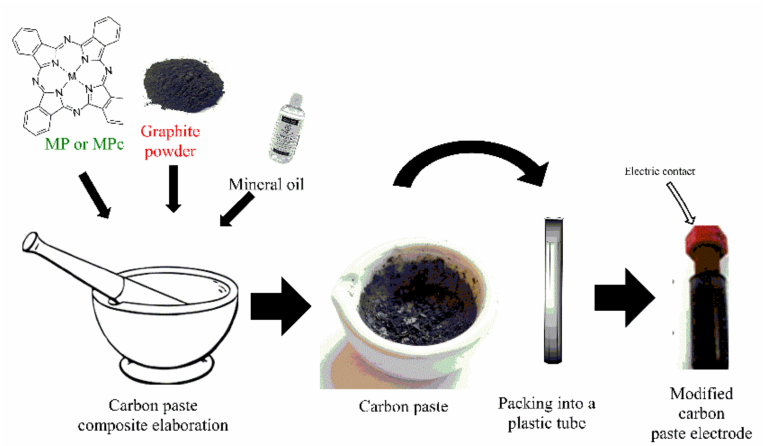
Figure 3. A simple modified CPE’s elaboration